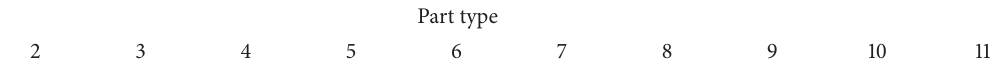
Table 4: Partial input data for Example 1.